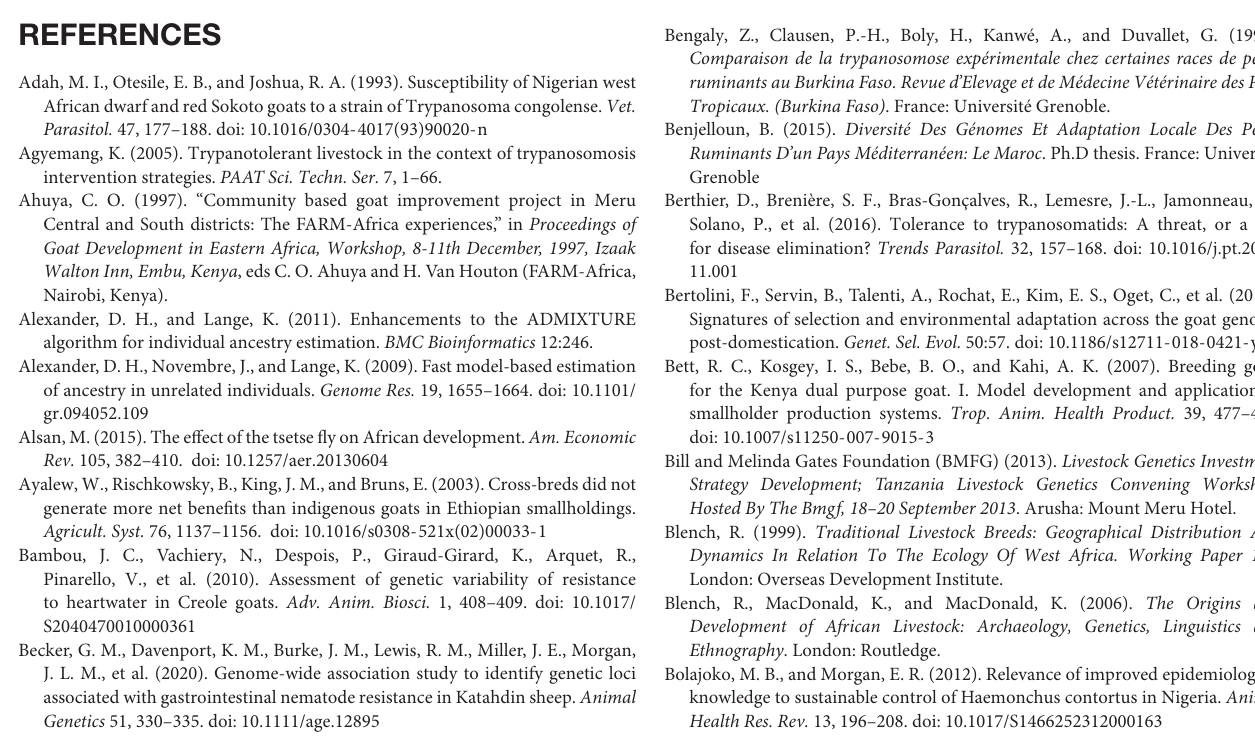
Table 3 ) are symbolized by stars; red stars: SNPs identified by PCAdapt (and plots associated); green stars: SNPs identified by LFMM following the infestation ranking (and plots associated). Supplementary Table 1 | Initial list of breeds for the constitution of the datasets. Supplementary Table 2 | Presentation of the bioclimatic variables used.